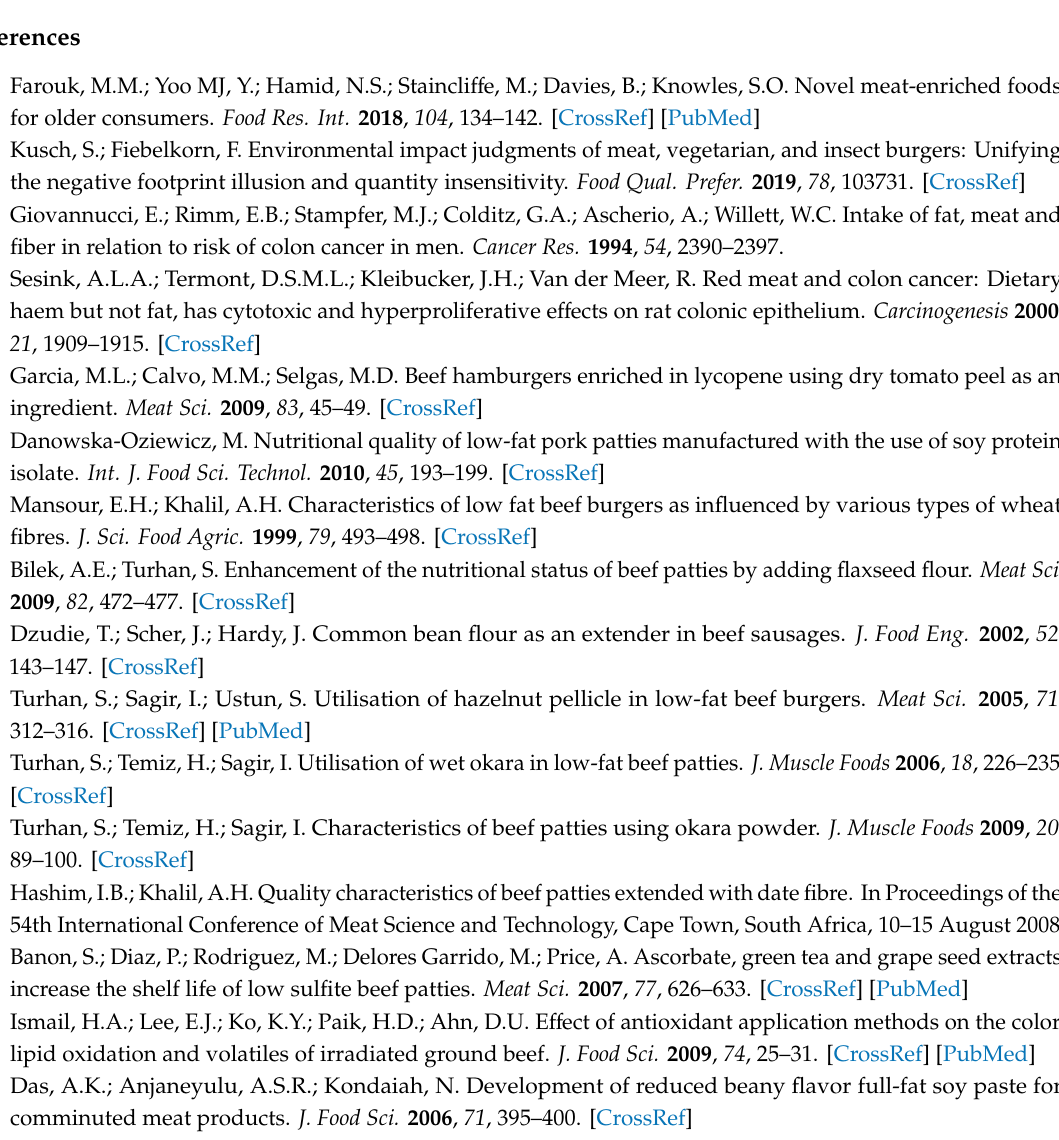
Table S1: Focus group themes for the consumption of takeaways, knowledge of the addition of additives to processed meat products, and relationship between colon cancer and the consumption of processed meat